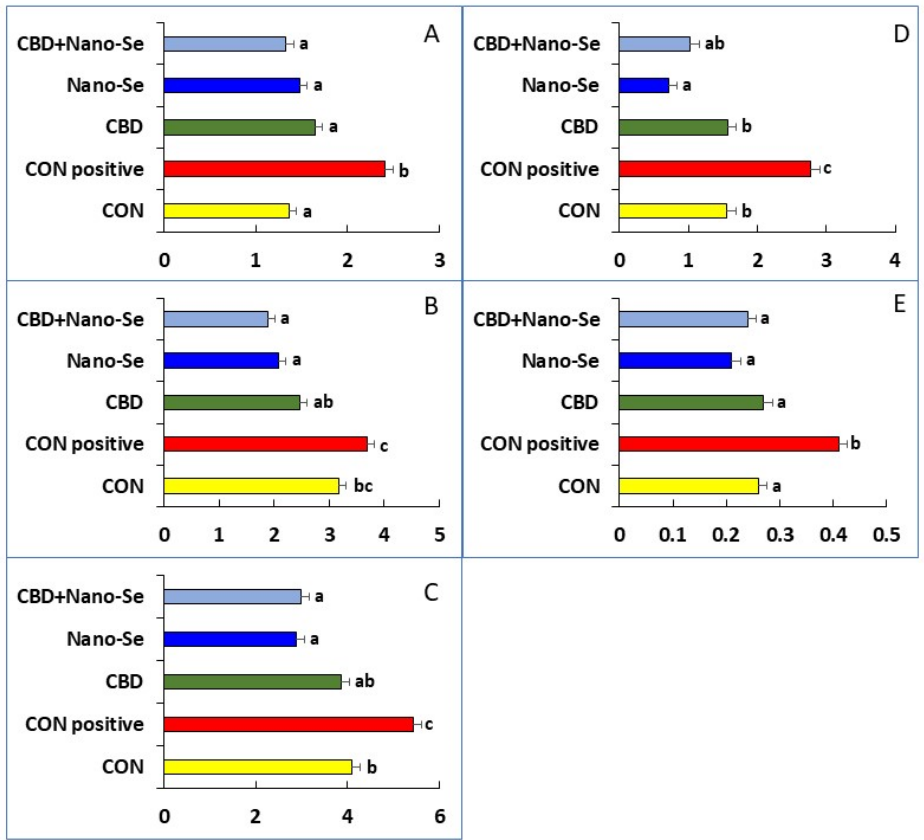
Figure 1. Excision activity (pmol/h/mg protein) of 3,N4-ethenodeoxycytosine ( A ), 1,N6- ethenodeoxyadenosine ( B ), 8-oxo-guanine ( C ), formamidopyrimidine (fapy)-DNA glycosylase ( D ) and human alkyl adenine DNA glycosylase ( E ). CON—untreated control group; CON positive—birds fed a CON diet challenged with Clostridium perfringens on days 15, 16, 17 and 18 of age; CBD—CON positive + dietary supplementation with cannabidiol; Nano-Se—CON positive + dietary supplementation with nano form of selenium; CBD + Nano-Se—CON positive + dietary supplementation with both additives. a,b,c Different letters represent significant differences ( p <0.001). Error bars represent mean standard error values for 8 birds in each dietary treatment.